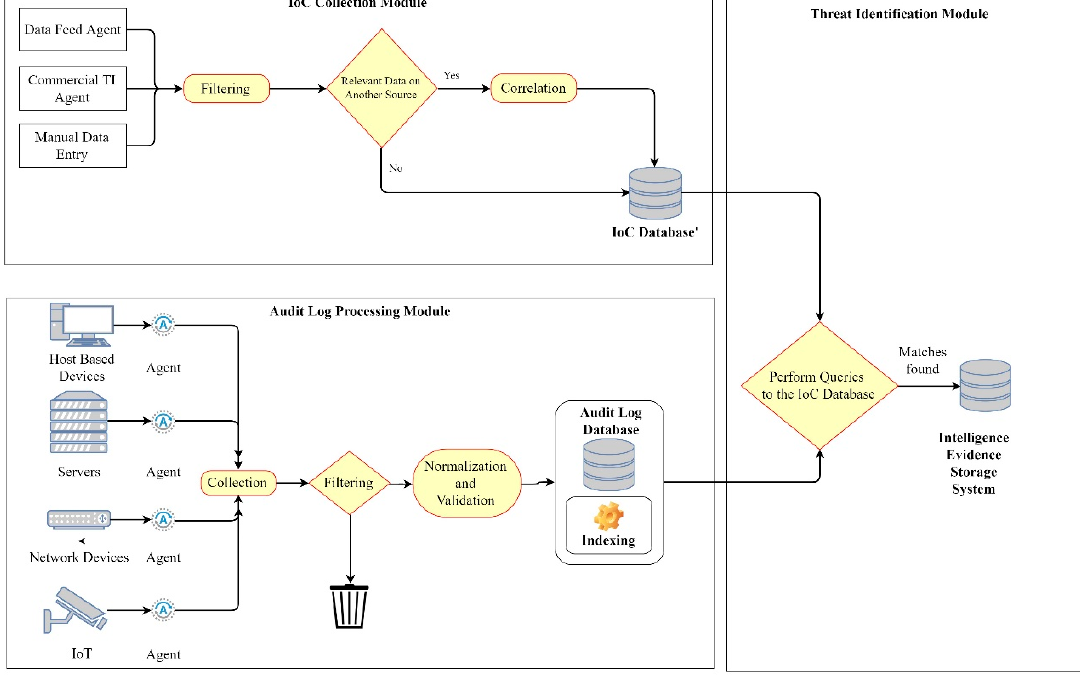
Figure 2. The threat intelligence informed digital forensic readiness process model [6].